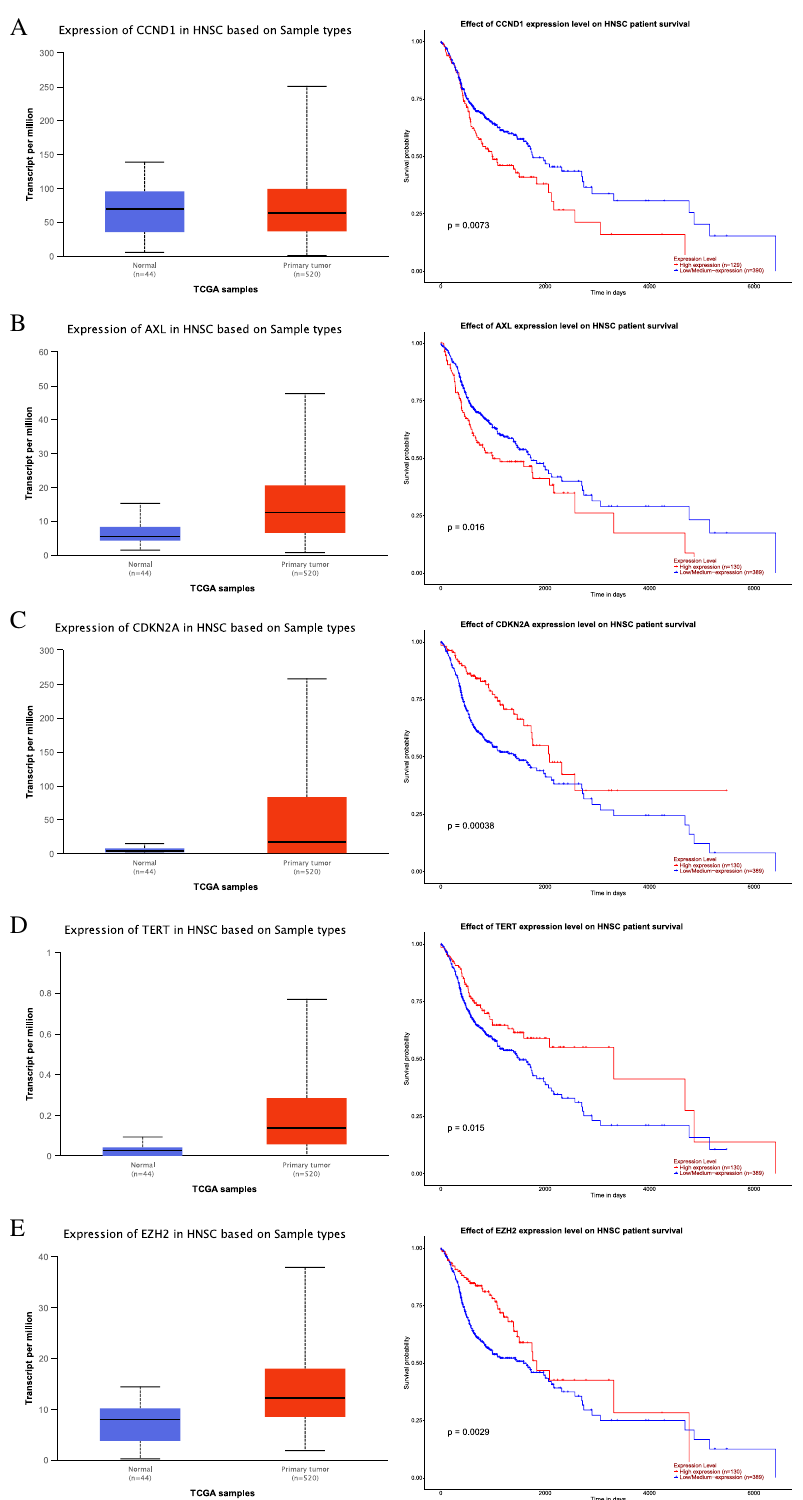
Fig. 5 Expression and survival analysis of significant hub genes. A Expression and survival analysis of CCND1. B Expression and survival analysis of AXL. C Expression and survival analysis of CDKN2A. D Expression and survival analysis of TERT. E Expression and survival analysis of